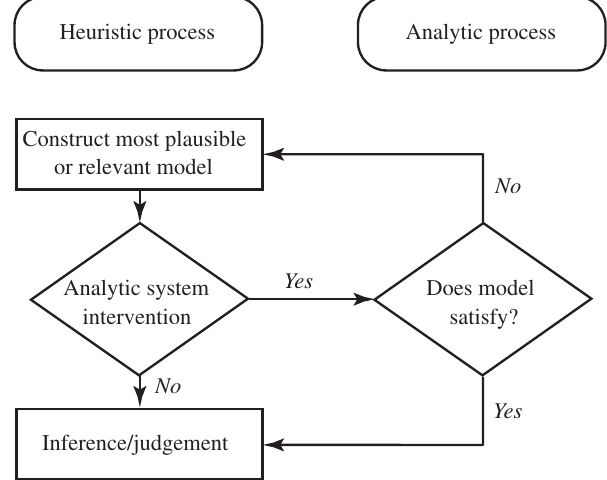
FIG. 1. Diagram illustrating reasoning process based on the heuristic-analytic